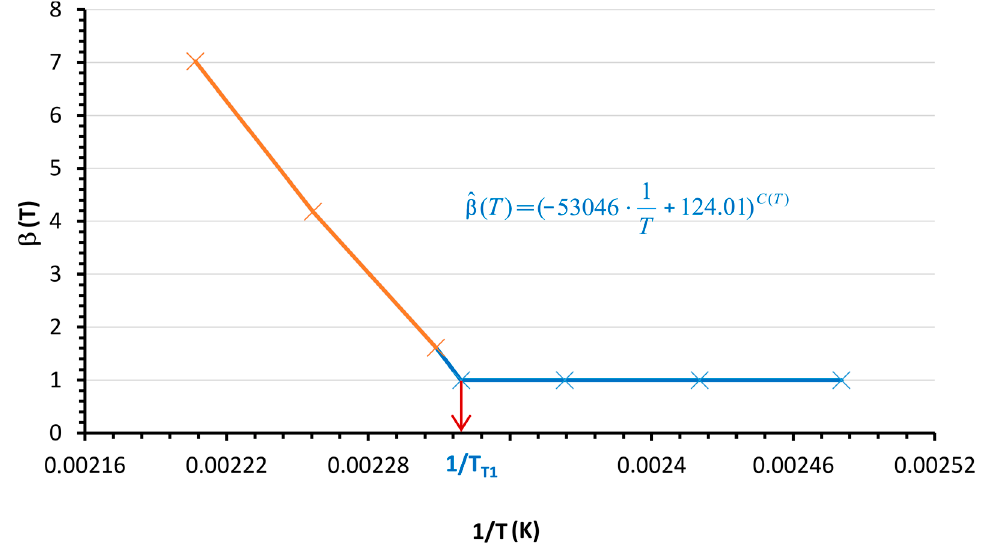
Figure 9. Parameter of the shape of the Weibull distribution depending on the reciprocal temperature.